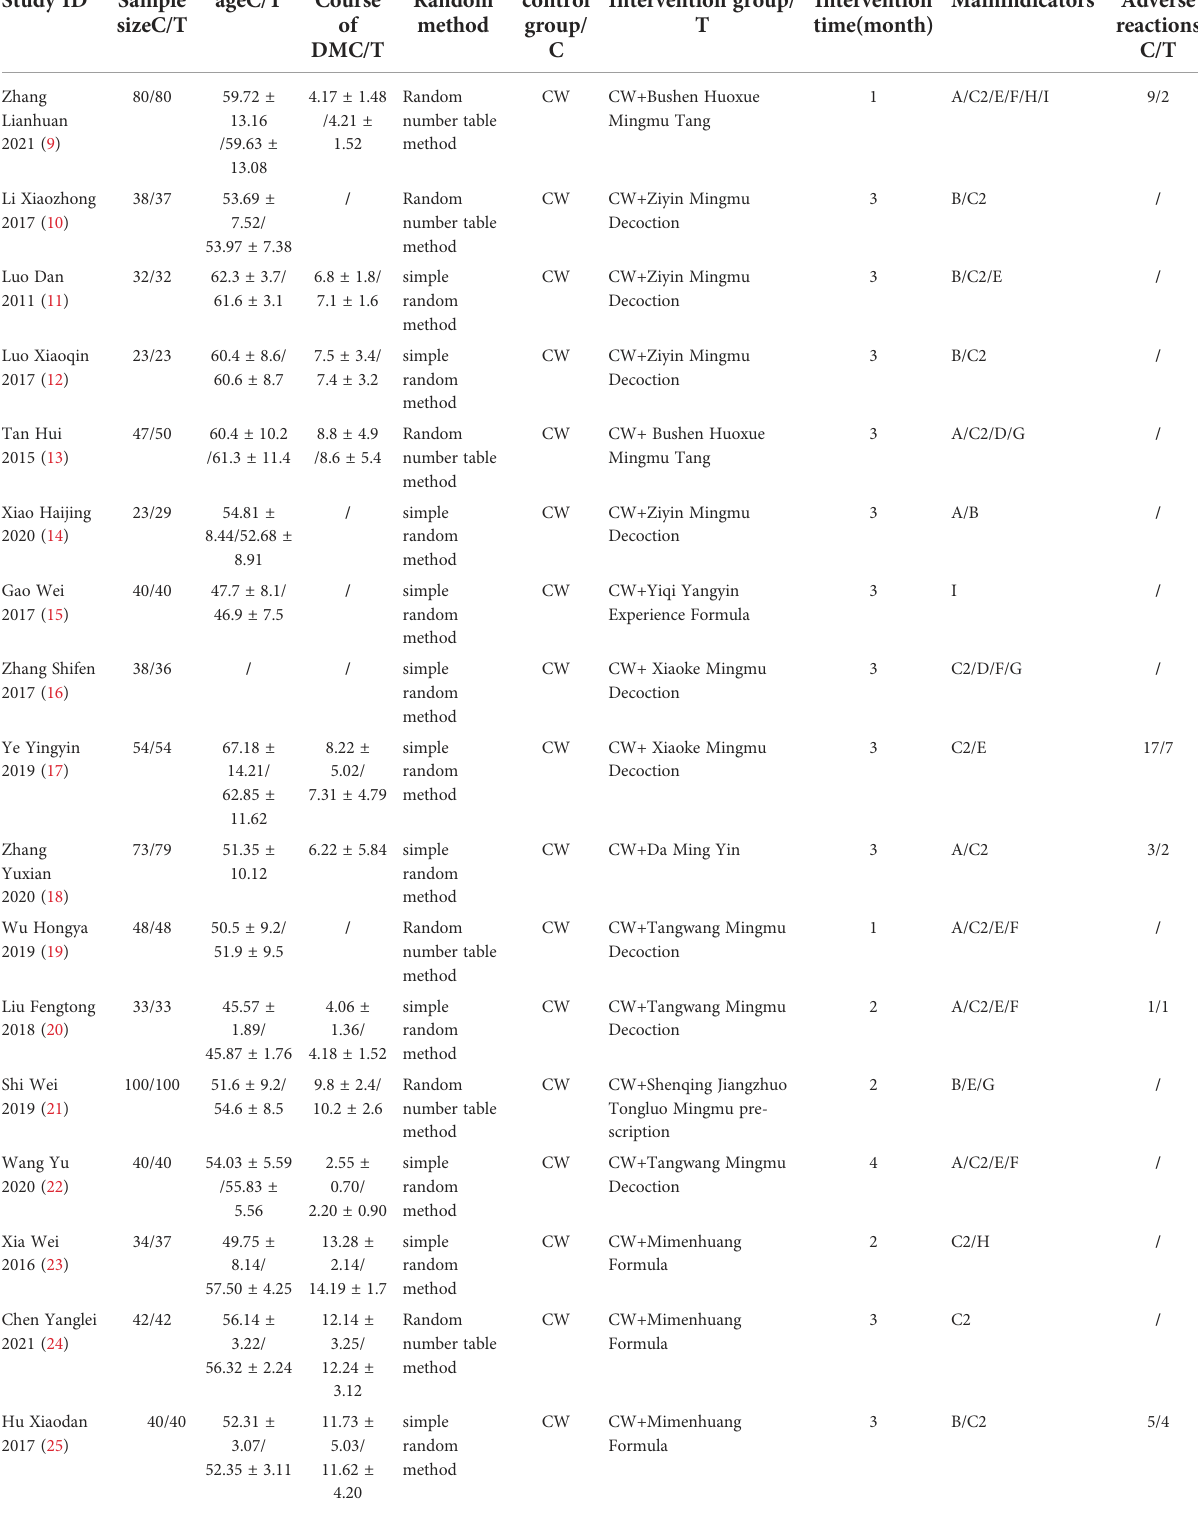
TABLE 1 Basic characteristics of included